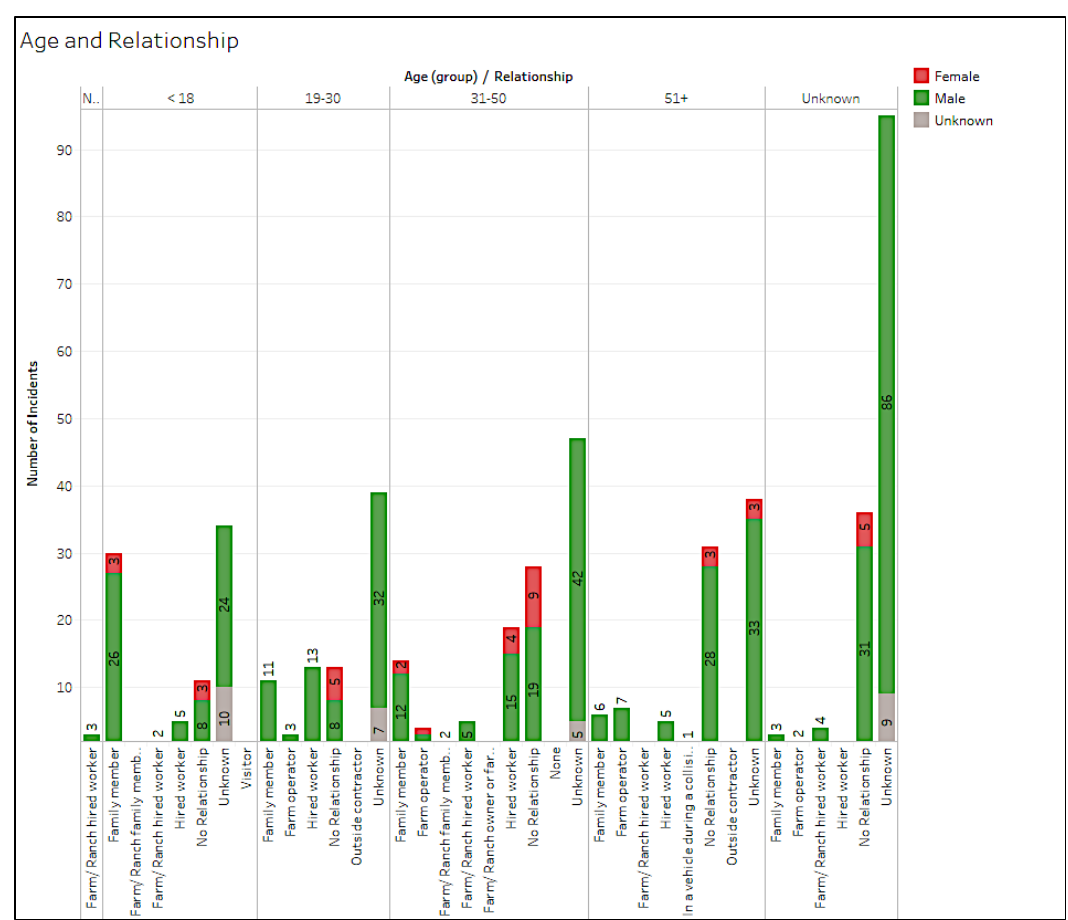
Figure 9. Dashboard software display of victim age and relationship to farm.